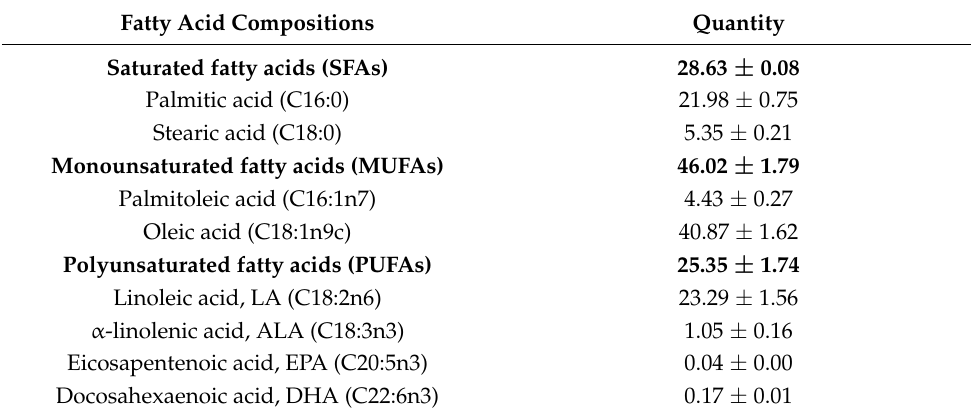
Table 1. Fatty acid compositions of CO.